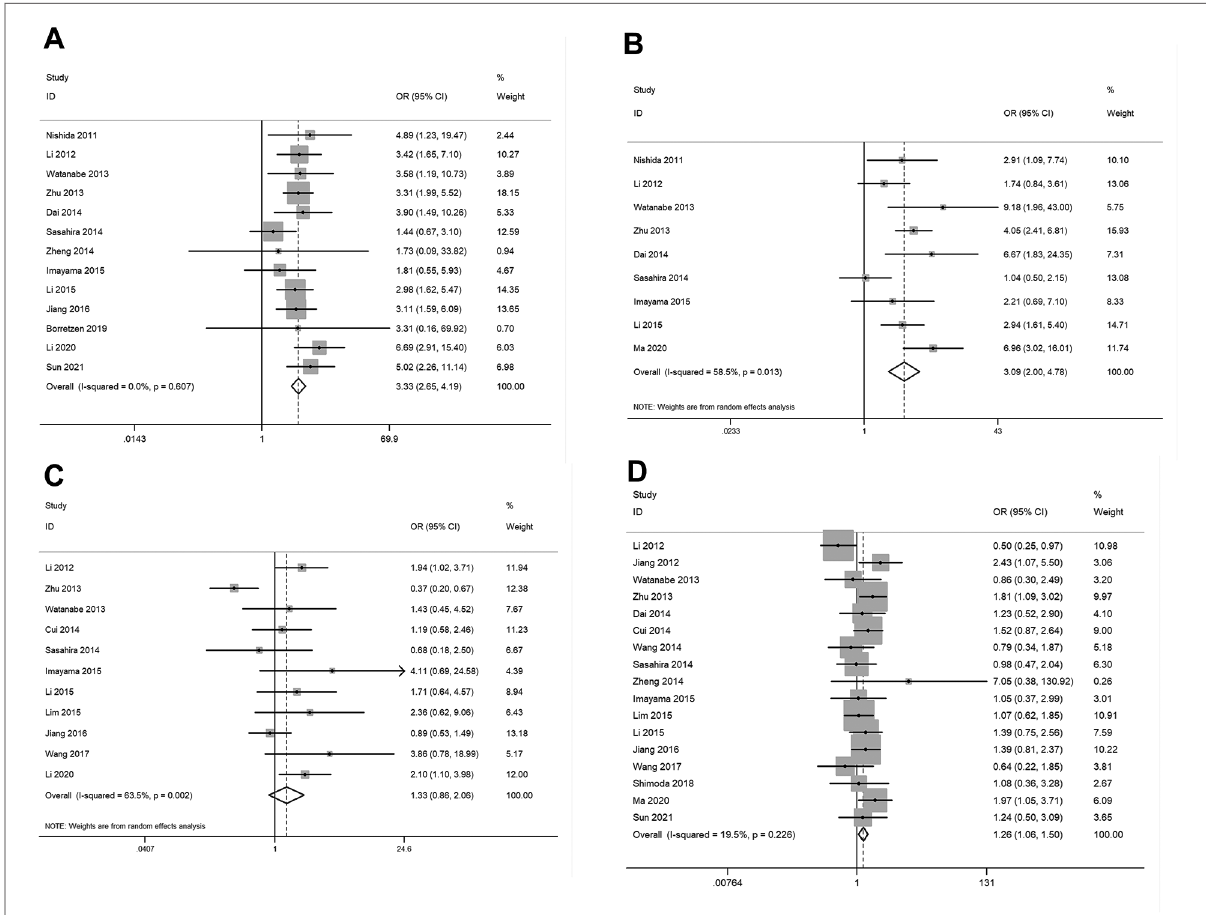
FIGURE 3 Forest plots for the relationship between FOXC2 overexpression and clinical and pathological characteristics. ( A ) Lymph node metastases, ( B ) TNM stage, ( C ) tumor differentiation, ( D ) patient